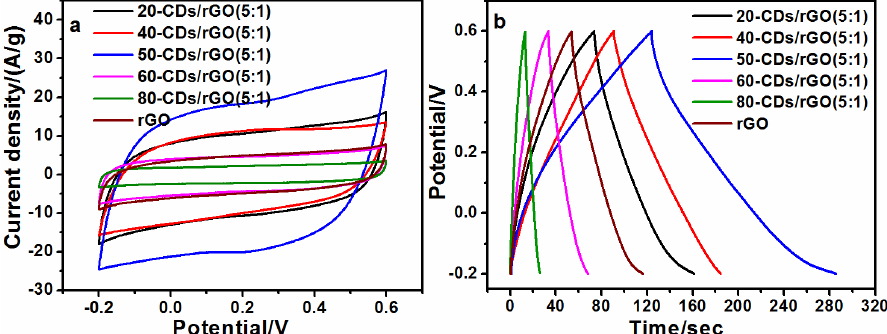
Figure 6. ( a ) CV curves of the 20-CDs/rGO, 40-CDs/rGO, 50-CDs/rGO, 60-CDs/rGO, 80-CDs/rGO and rGO electrodes at a scan rate of 0.2 V/s; ( b ) GCD curves of the 20-CDs/rGO, 40-CDs/rGO, 50-CDs/rGO, 60-CDs/rGO, 80-CDs/rGO and rGO electrodes at a current density of 1 A/g.